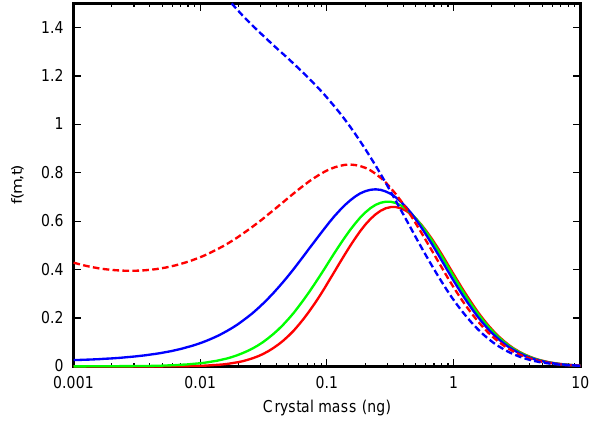
Fig. 1. f ( m,t ) for various times t under sublimation with a = − 0 . 004 (approximatly for − 50 ◦ C, 250 hPa, RH i = 98 %). t = 0 (solid red, the initial log–normal distribution), and t = 10 , 30 , 60 , 120 s (solid green and blue, dashed red and blue).